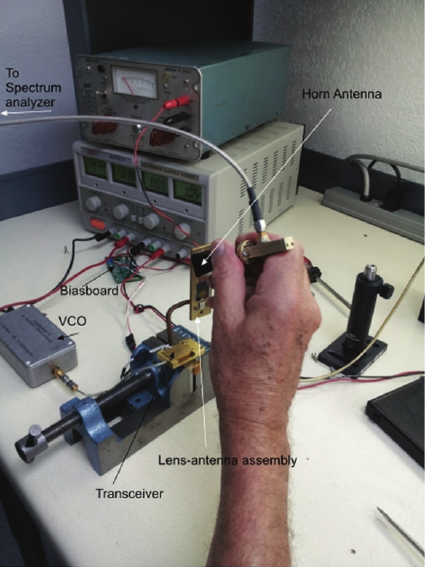
Figure 17: Fabricated Rotman lens combined with a microstrip array antenna.